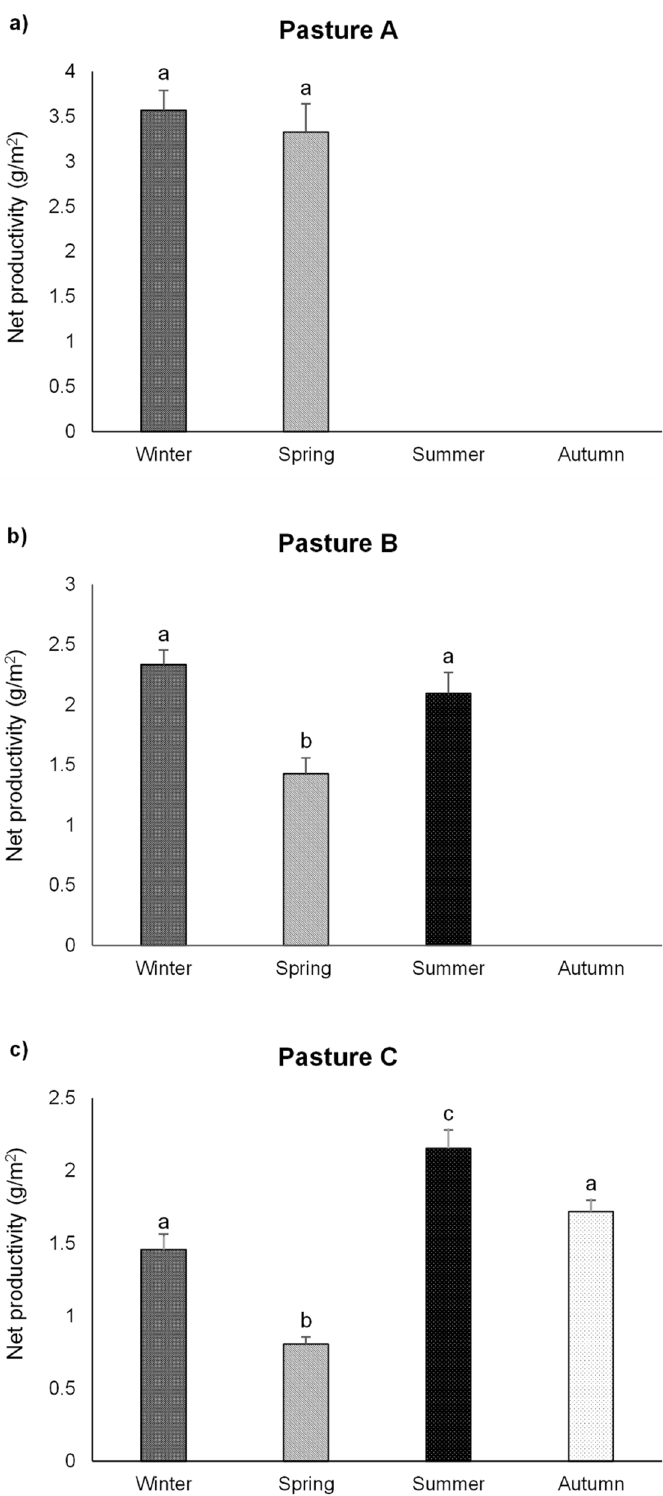
Figure 3. Variation of forage net productivity plants among the four sampling dates (winter, spring, summer and autumn) in: ( a ) pasture A, ( b ) pasture B and ( c ) pasture C. Different letters above each bar indicate significant differences in net productivity among sampling dates (Tukey test, p < 0.05).